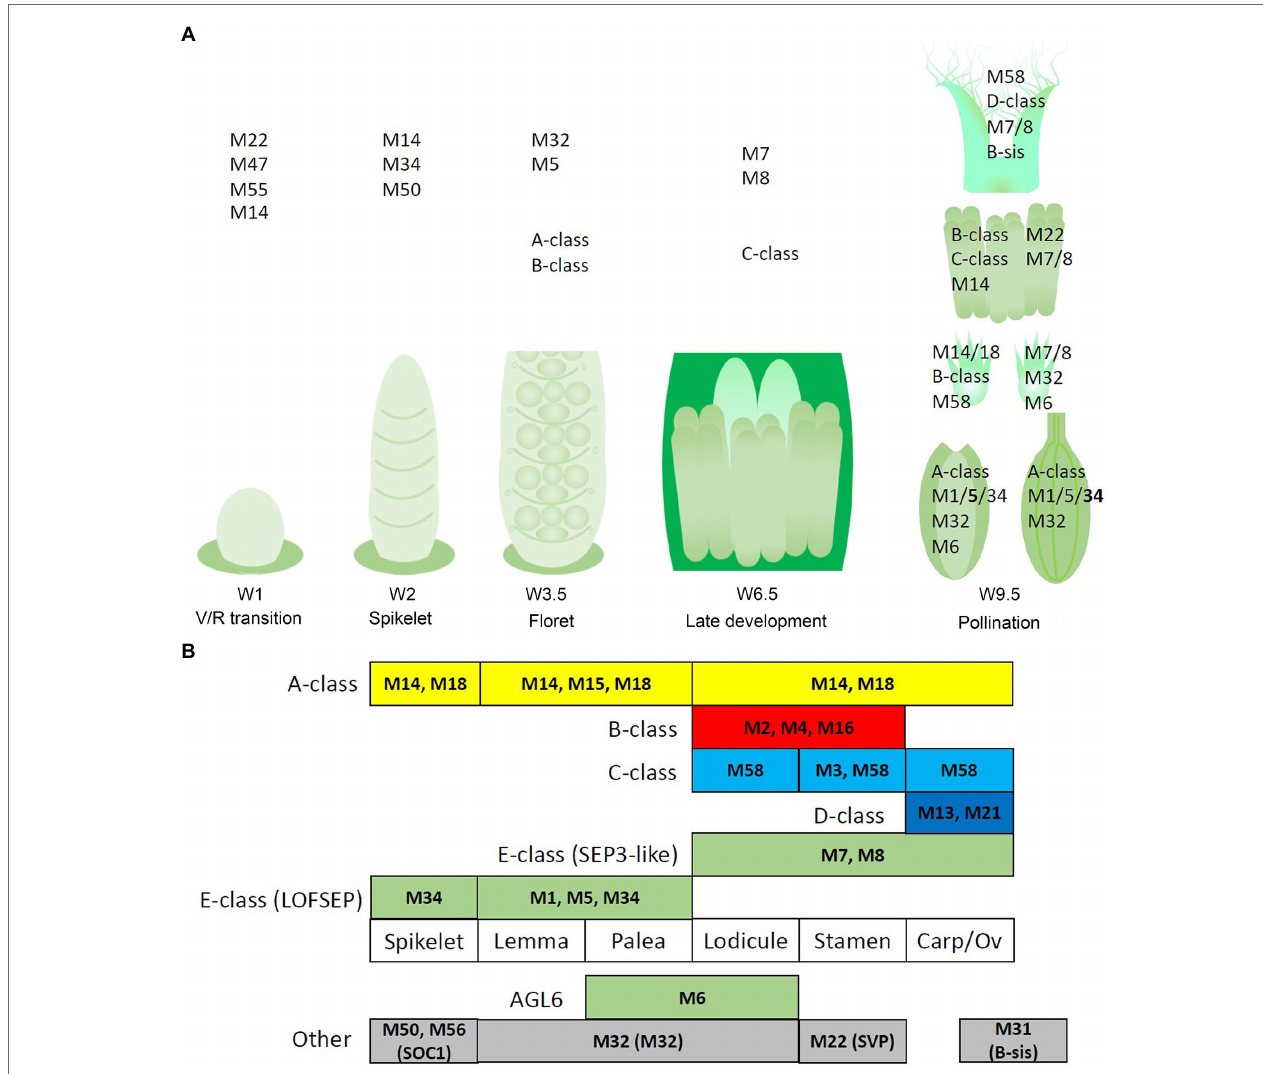
FIGURE 9 | Potential regulatory networks of MIKCc MADS-box genes in barley inflorescence and floral development. In this figure, ‘MADS’ is abbreviated as ‘M’. (A) Prominent expression of the MIKCc MADS-box genes through developmental stages and the floral organs of barley. (B) Schematic of an adapted ABCDE model for barley floral development. Canonical ABCDE genes are depicted above the floral organs where they are expressed, while additional expressed MIKCc genes are shown below. Transcript before the start of floral organ primordia initiation is given in the leftmost column, tentatively labelled